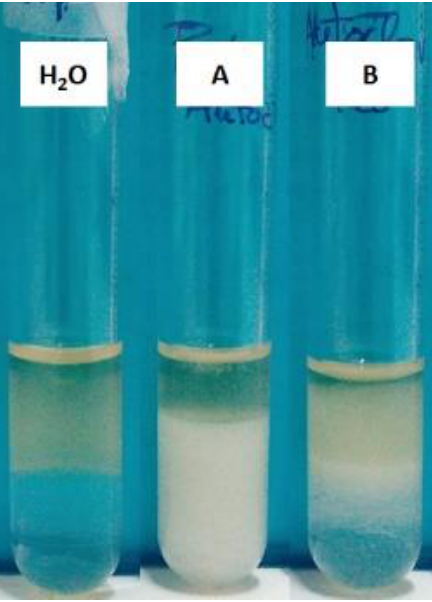
Figure 7. Emulsifying activity (E 24 ) of the concentrated extract from a culture with fructose and DBT ( A ) before and ( B ) after autoclaving (121 °C) for 30 min. Ultrapure water was used as a negative control.